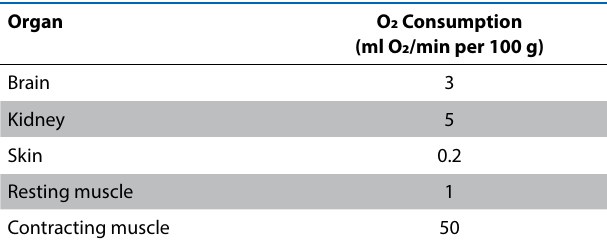
Table ll: Oxygen consumption by organs in the human body, measured in ml O2/min per 100 g.⁹